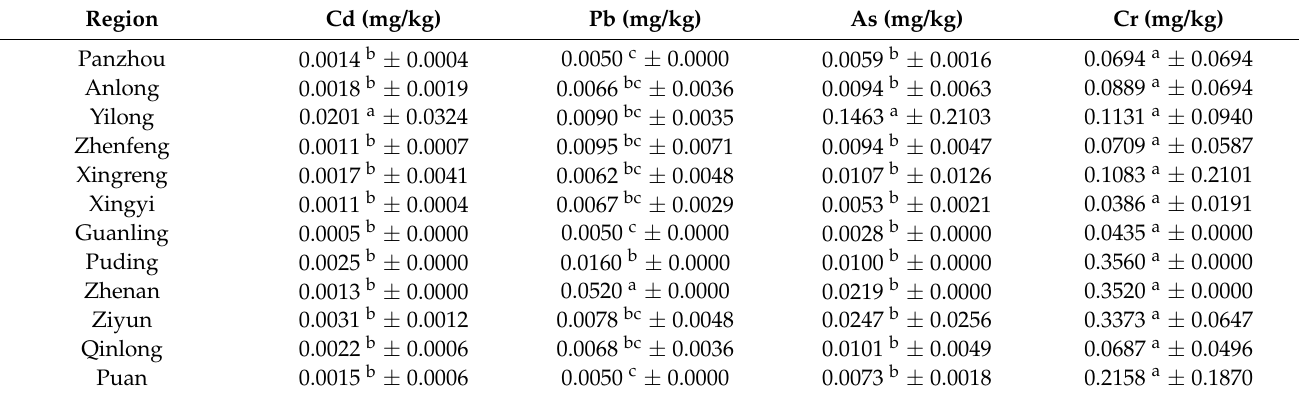
Table 2. The mean contents of five heavy metals in coix seeds from 12 cities in Guizhou Province.